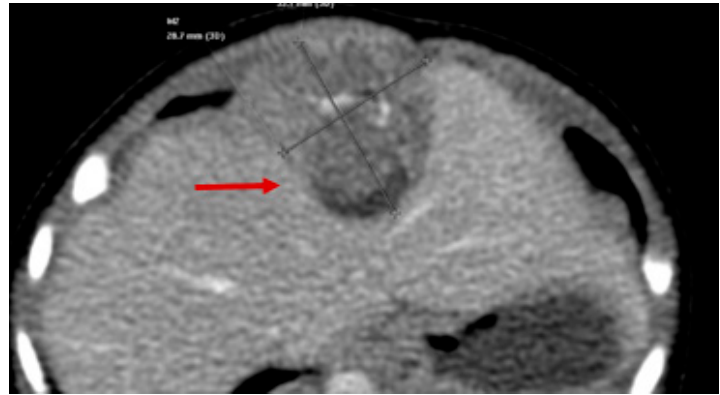
Figure 3. Axial CT showing Diaphragmatic Rhabdomyosarcoma (red arrow).